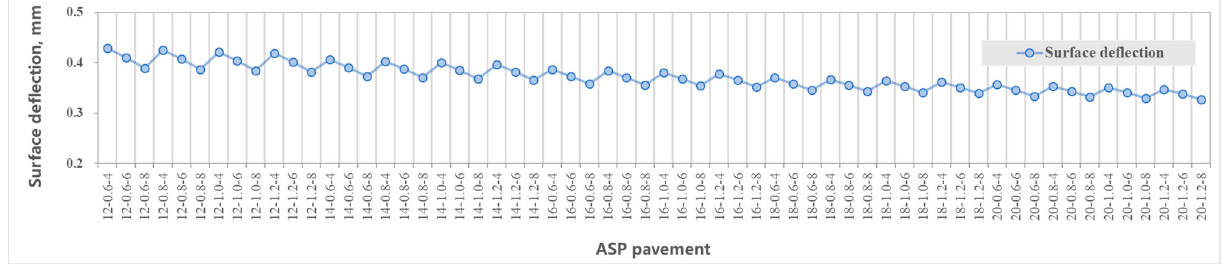
Figure 8. Surface deflection of ASP pavement.